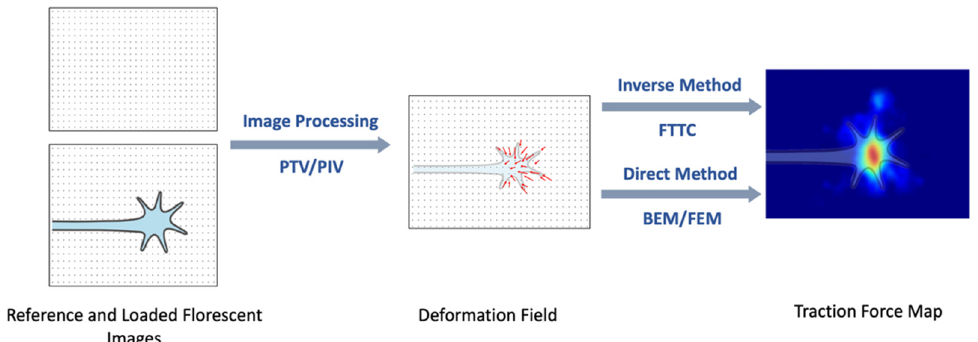
Figure 3. Schematic description of how traction forces are reconstructed from the measured substrate displacement (deformation field). The figure shows the schematic reconstruction for a growth cone, which leads the extension of an axon. The bright red area on the right image corresponds to the region where the growth cone exerts high traction forces.